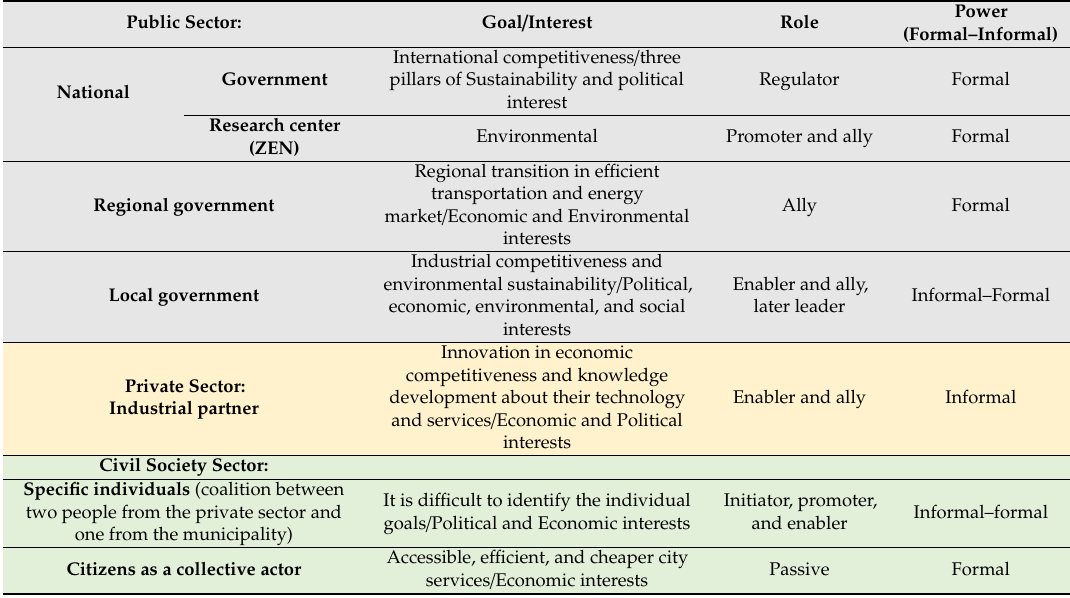
Table 3. Governance in the development of a smart city in